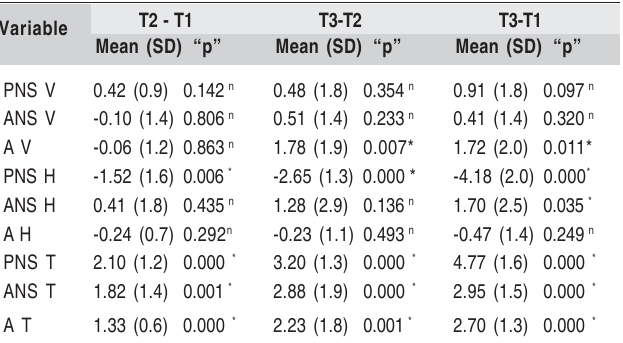
Fig. 3 . Maxillary remodeling between T1 and T2 (upper data) and between T2 and T3 (lower data). The horizontal/vertical components are proportional in scale. Each square represents 0.5 Table 4 - Maxillary growth (vertical, horizontal and total) and remodeling (in mm).